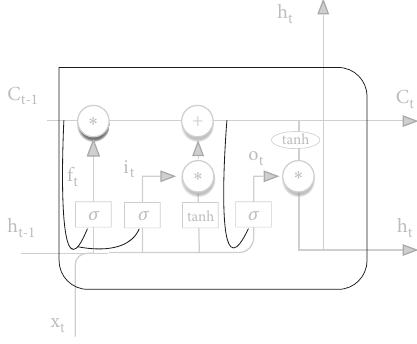
Figure 4: Variant structure 1 of